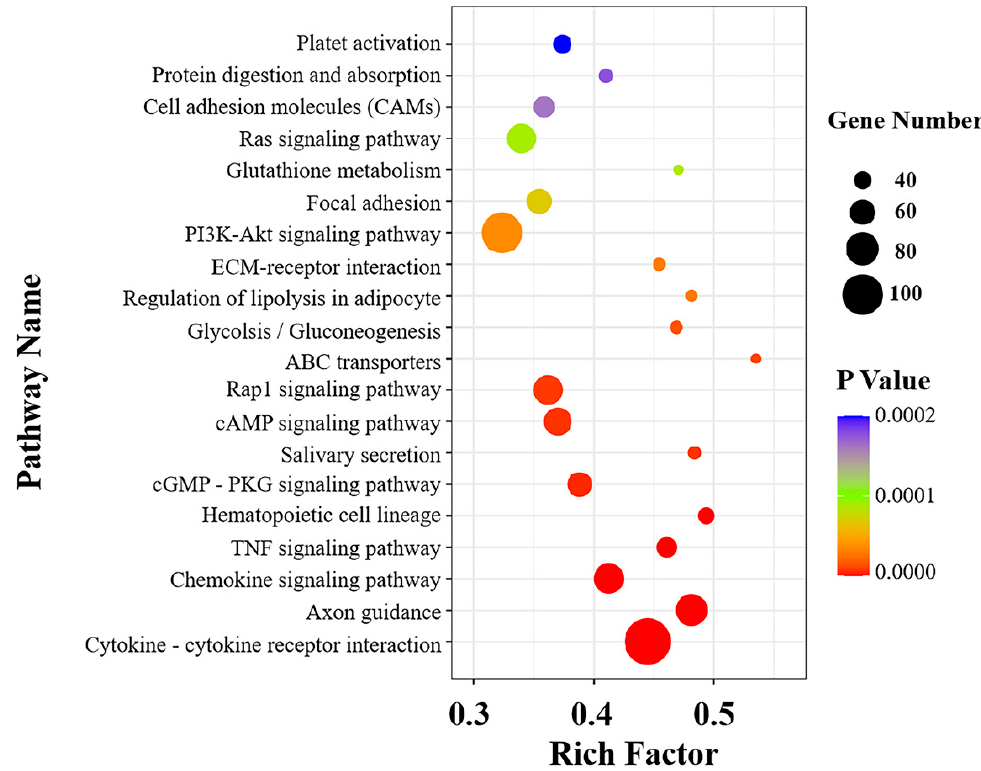
Figure 8. Functional scatter diagram of significant enrichment of KEGG. The vertical axis represents the annotation information of the function, and the horizontal axis represents the rich factor corre- sponding to the function (the number of different genes annotated to the function was divided by the number of genes annotated to the function). The size of p -value is represented by the color of the point. The smaller the p -value is, the closer the color is to red. The number of different genes contained in each function is indicated by the size of the dots.